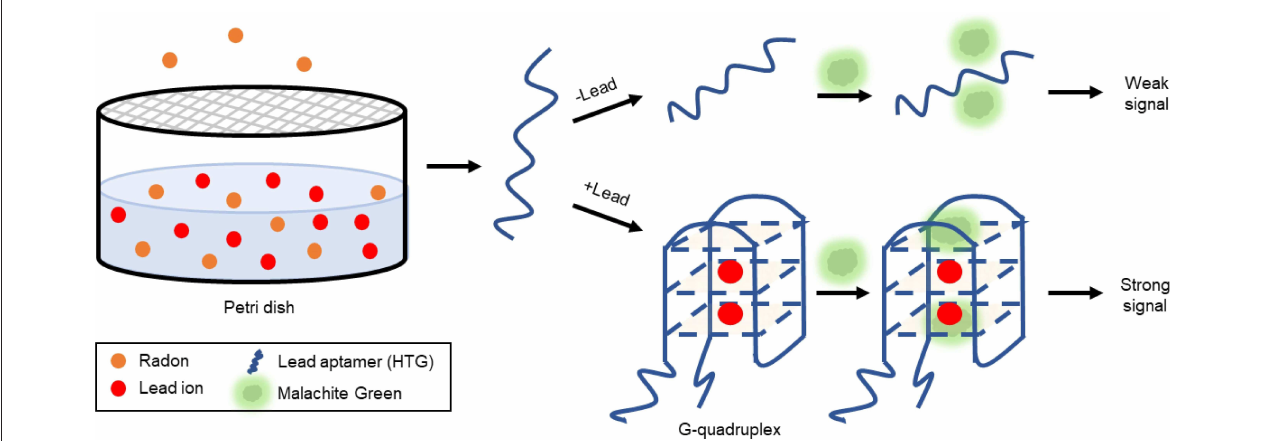
FIGURE 8 | Indirect detection of accumulated radon via aptamer-based lead ion detection (Li S. et al., 2018).